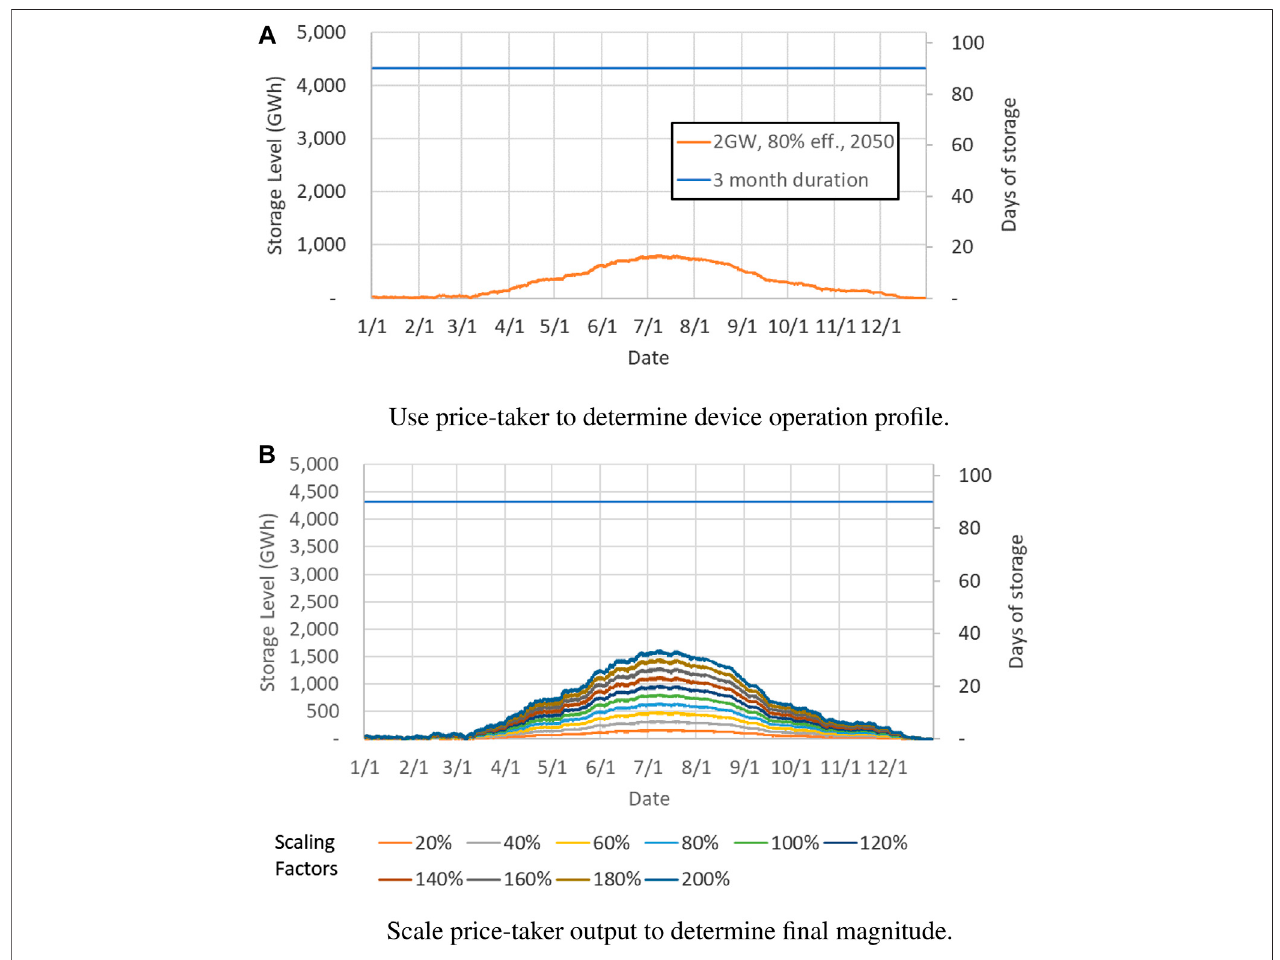
FIGURE 7 | Illustration of the price-taker duration representation with scaling factors for the energy storage with 2 GW capacity and 80% ef fi ciency.